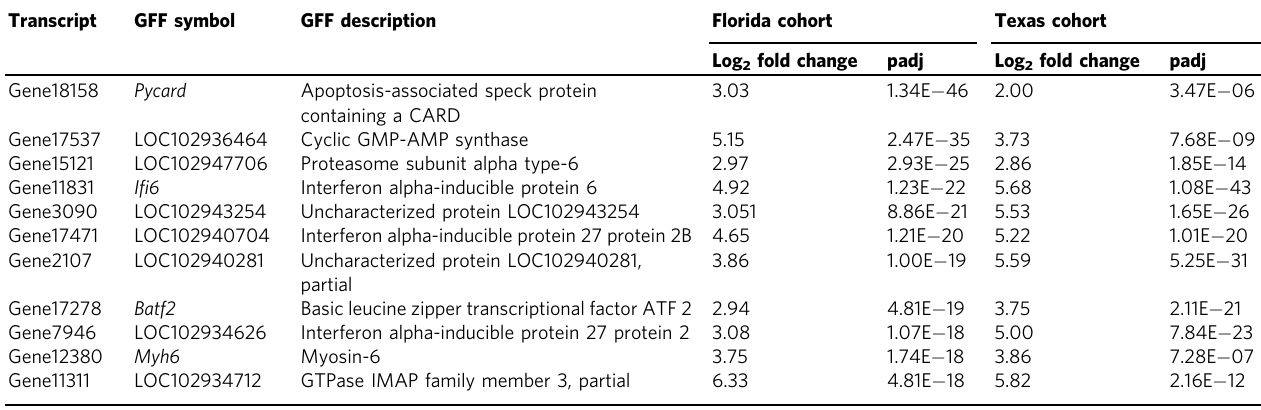
Table 1 Shortlisted putative predictive biomarkers for rehabilitation outcome, as detected by RNA-seq of tumor tissue.